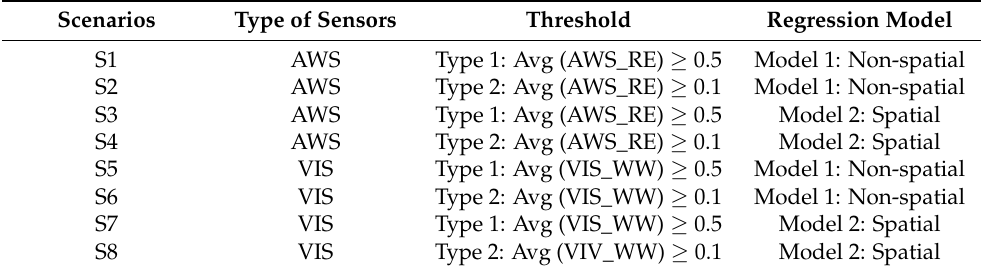
Table 2. The eight scenarios made by considering two sensors, two thresholds, and two models.